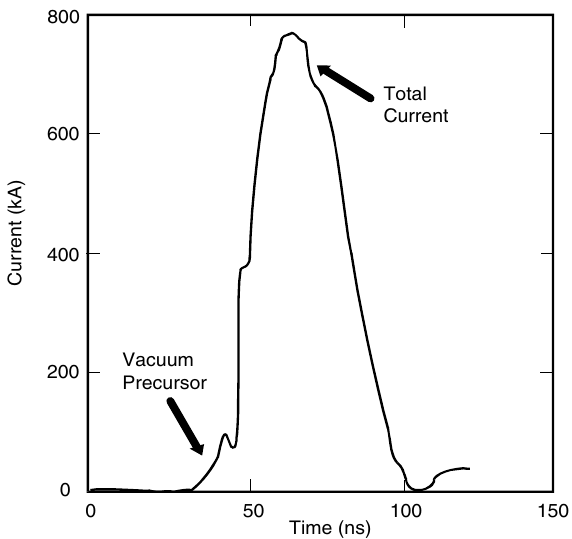
FIG. 34. Hermes-III output current (showing vacuum precur- sor) (from Ref.